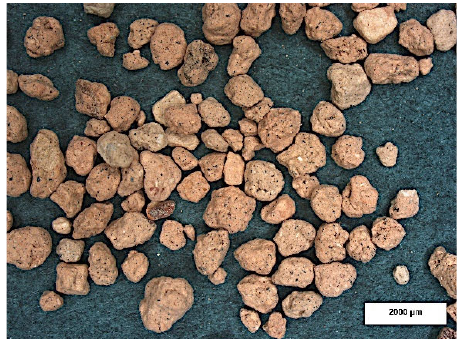
Figure 13. Microscope picture of commercial sorbent.